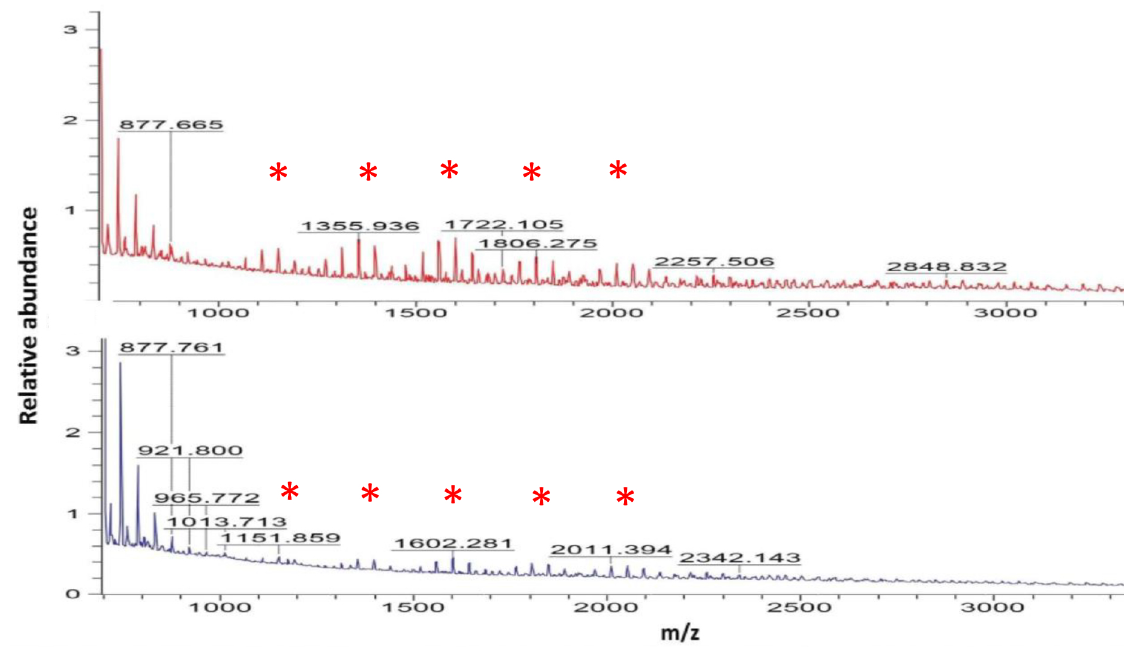
Figure 2. MALDI-TOF mass spectrometry of EPS extracts. Spectra of SN-induced A26Sfp ( A ) compared to A26SfpSN EPS extracts ( B ). Asterisks indicate oligosaccharide chain relative abundance compared in detail in Table (MALDI). Table 3. Paenibacillus polymyxa A26Sfp and A26SfpSN culture filtrate polysaccharide MALDI-TOF